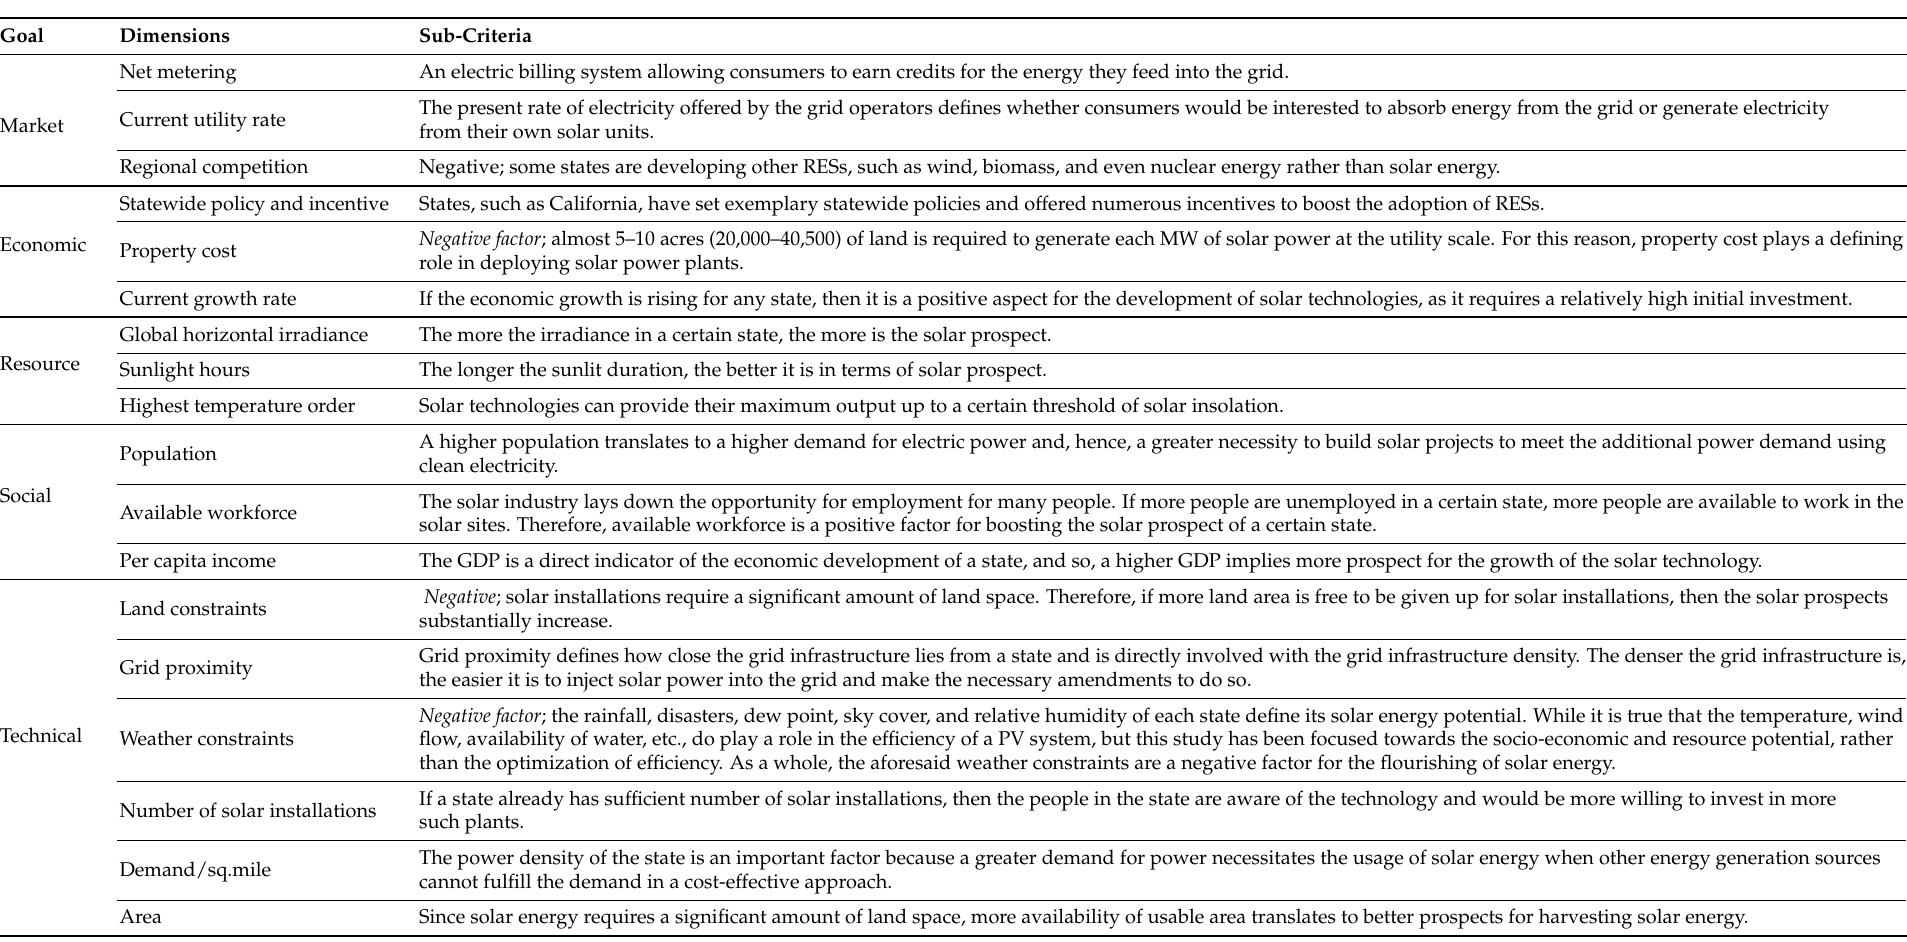
Table 4. Considered factors according to the five